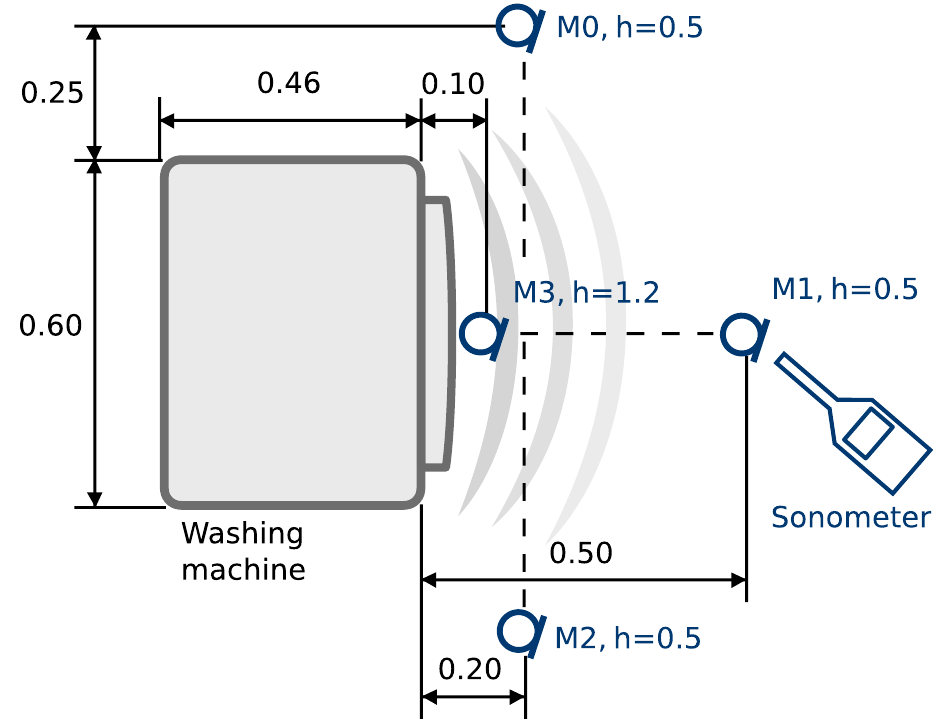
Figure 1. A scheme of the measurement system. All dimensions are given in